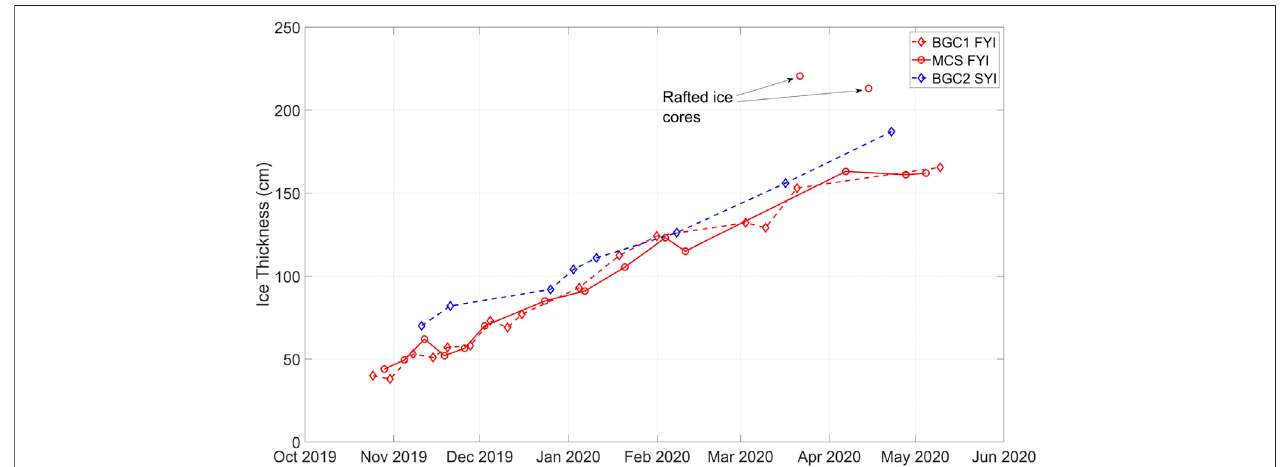
FIGURE8| MaximumicethicknessobservationsforBGC1,themaincoring(MCS)FYIsite,andtheBGC2SYIsitesareplottedasafunctionoftime.SincetheMCS SYI site had a highly variable SYI thickness overlying the insulated FYI, it is not presented. Site BGC3 is not included, because the initial thickness was affected by ice